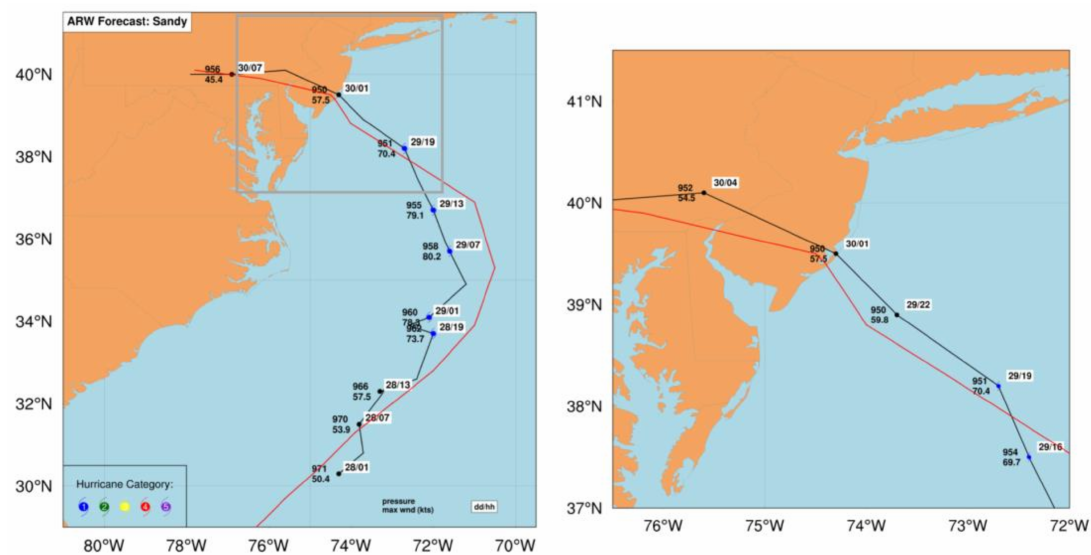
Figure 4. Same as Figure 2 except track is presented for the WRF 12 km